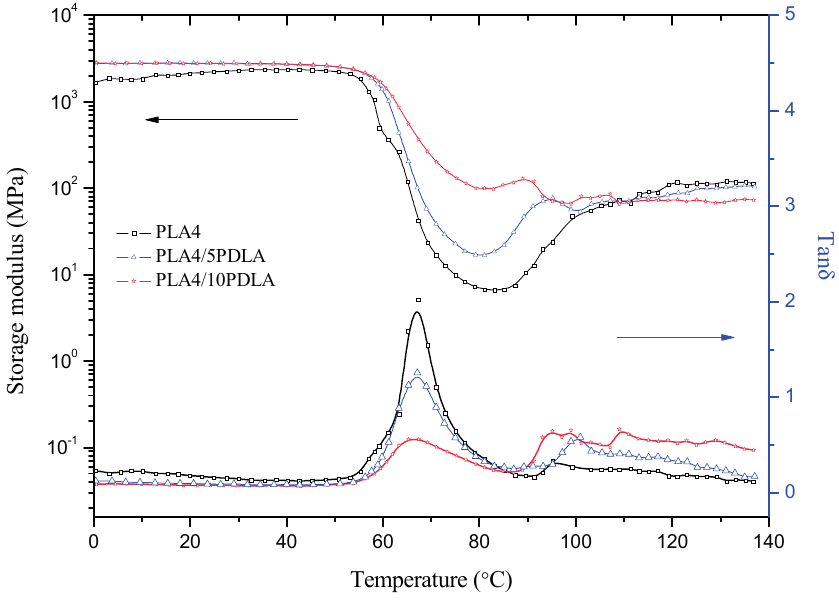
Figure 6. Temperature dependence of the storage modulus and tan δ of PLA4 binary composites with Poly( D -lactic acid)